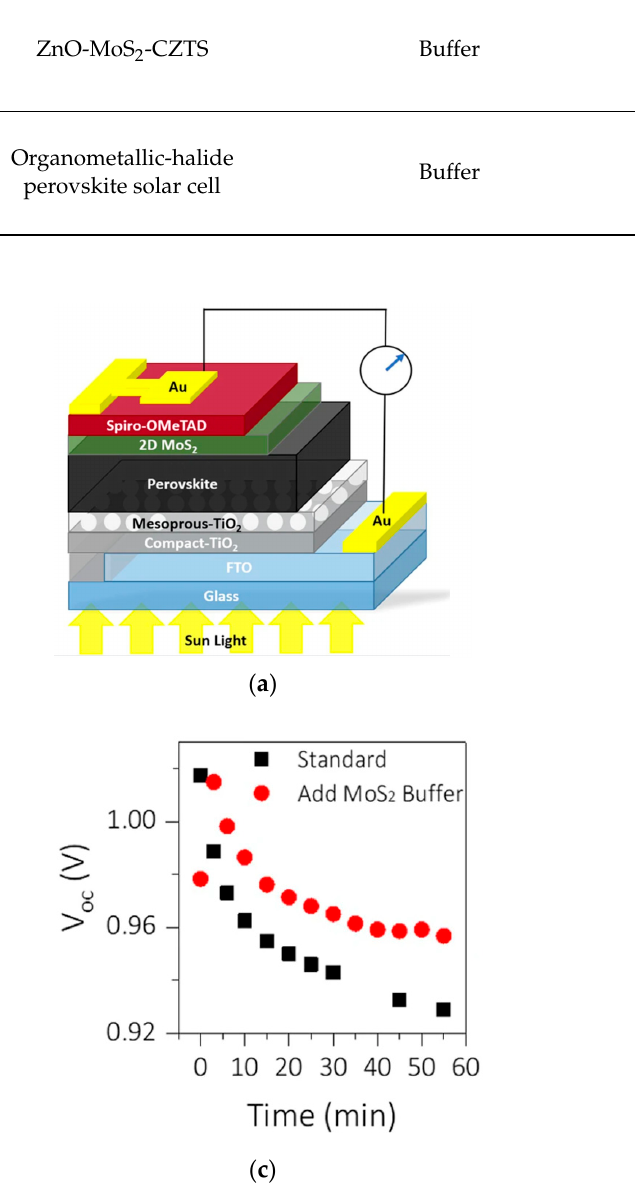
Figure 5. Structure and characteristics of organometallic-hallide pervoskite solar cells: ( a ) schematic of pervoskite solar cell with 2D MoS 2 as a buffer layer; ( b ) power conversion efficiency of standard solar cell and modified cell with MoS 2 layer; ( c ) V oc versus time for standard and modified cells; ( d ) J sc versus time for standard and modified cells. Adapted from [120]. npj 2D Materials and Applications Nature 2020.